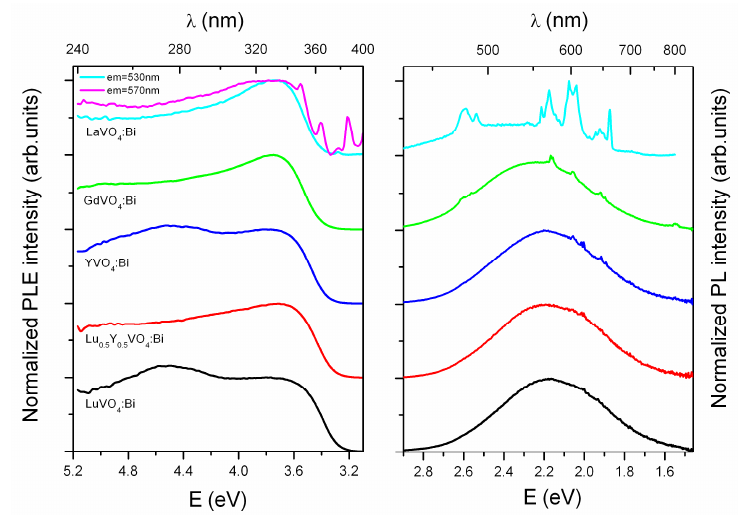
Figure 6. Normalized PLE ( left ) and PL ( right ) spectra of R VO 4 :Bi (1%) samples ( R = La, Gd, Y, Y 0.5 Lu 0.5 and Lu) measured at room temperature.